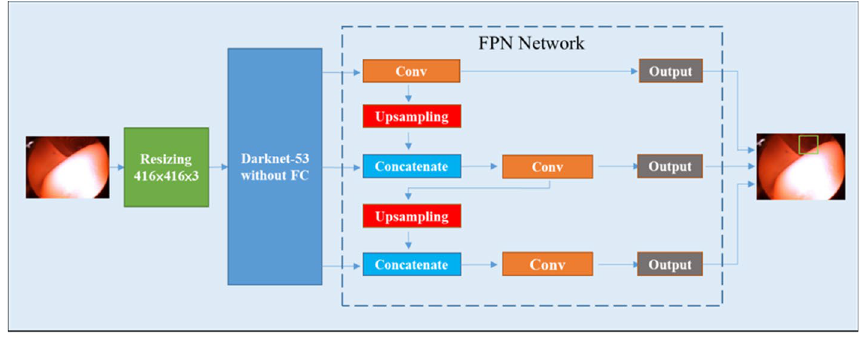
Figure 5. Workflow and model architecture of lumen detection. The input was the endoscopic image. The neural network inferenced the presence and position of the lumen. The output was the image with the bounding box as the detection of the lumen. FPN Feature Pyramid Network, Conv convolution layers, FC fully connected layers.